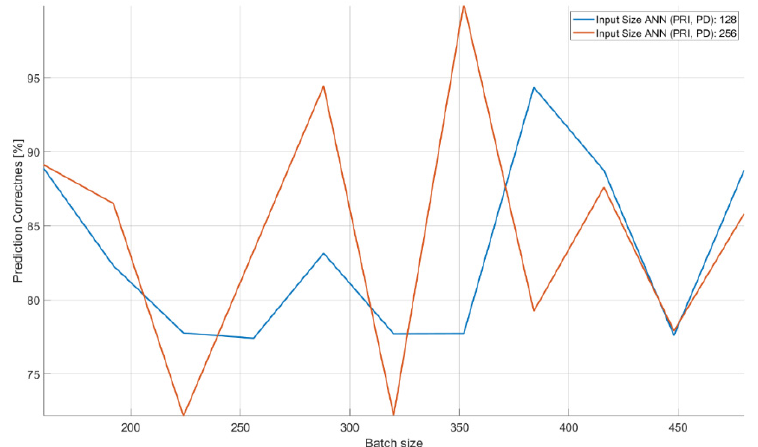
Figure 16. Effectiveness of recognizing radar signals on the basis of simultaneous analysis of three parameters (PD, PRI and TW) depending on the size of the training set and the number of iterations in the training algorithm.